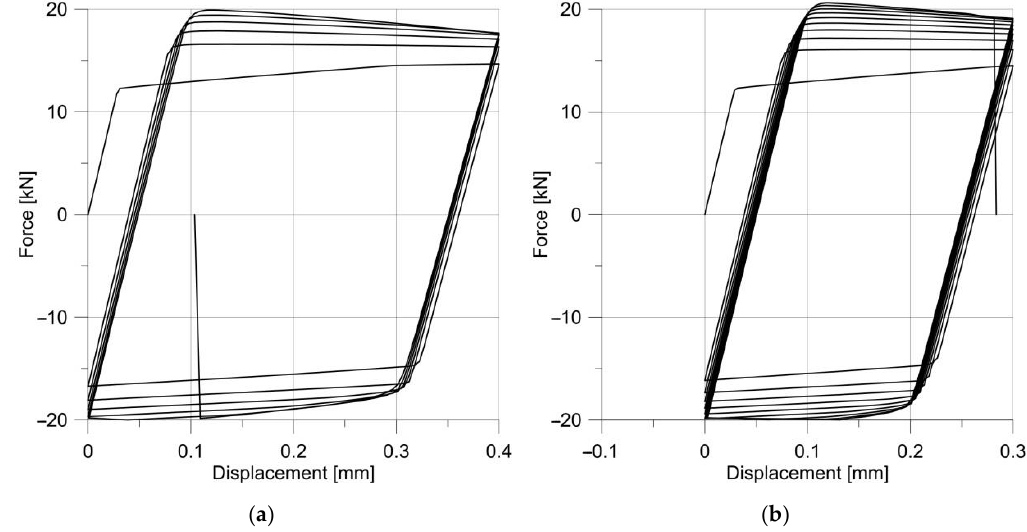
Figure 19. Change in the stress – strain hysteresis loop for smooth round specimens with a regular load ( a ) and a load decreased by 25% ( b ). Changes in the damage level at two characteristic points are shown in Figure 20.